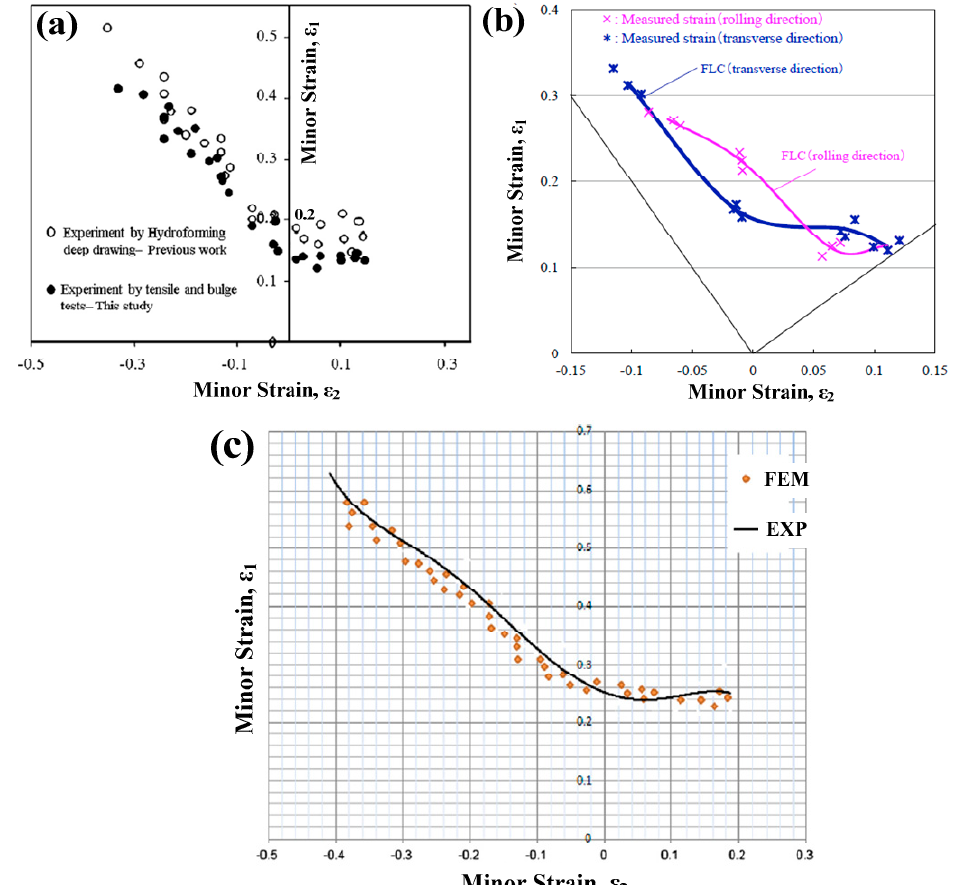
Figure 6. FLD of Ti-6Al-4V alloy sheet obtained by hydroforming at room temperature ( a ) at loaded rate of 1 mm/s [52] (Reprinted with permission from Ref. [52]. Copyright 2019, Results. Phys.), ( b ) 1.5 mm/s [54] (Reprinted with permission from Ref. [54]. Copyright 2018, 17th International Conference on Metal Forming.) and ( c ) 1.67 × 10 − 3 mm/s [53] (Reprinted with permission from Ref. [53]. Copyright 2010, Mater. Design.).